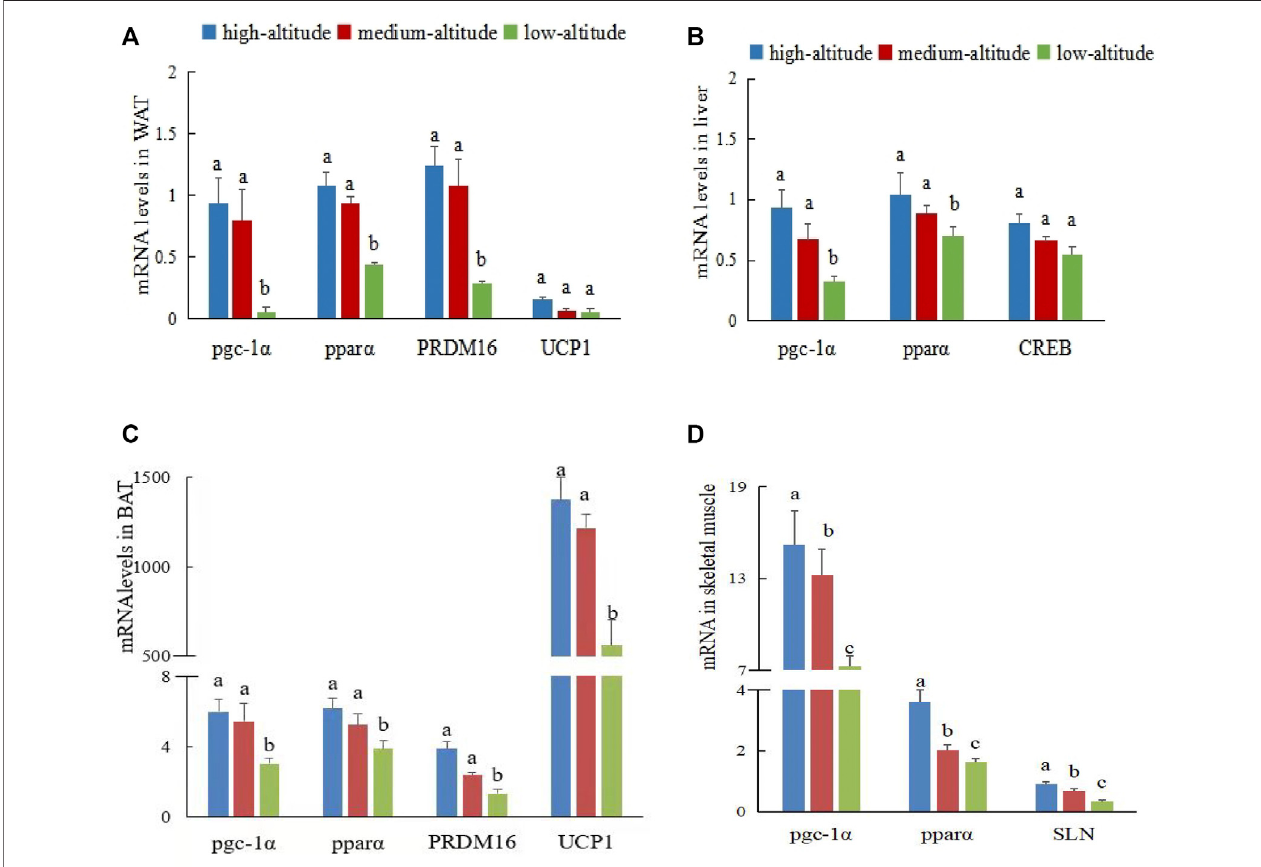
FIGURE 2 | Gene expression of different tissues in plateau pika from regions with different altitudes. Note: (A) Expression of pgc-1 α , ppar α , PRDM16 and UCP1 genesinWAT. (B) Expressionof pgc-1 α , ppar α and CREB genesinliver. (C) Expressionof pgc-1 α , ppar α , PRDM16 ,and UCP1 genesinBAT. (D) Expressionof pgc-1 α , ppar α , and SLN genes in skeletal muscle. Different lowercase letters indicate signi fi cant differences among elevations ( p < 0.05). Same lowercase letters indicate have not signi fi cant difference among elevations (ns p > 0.05).